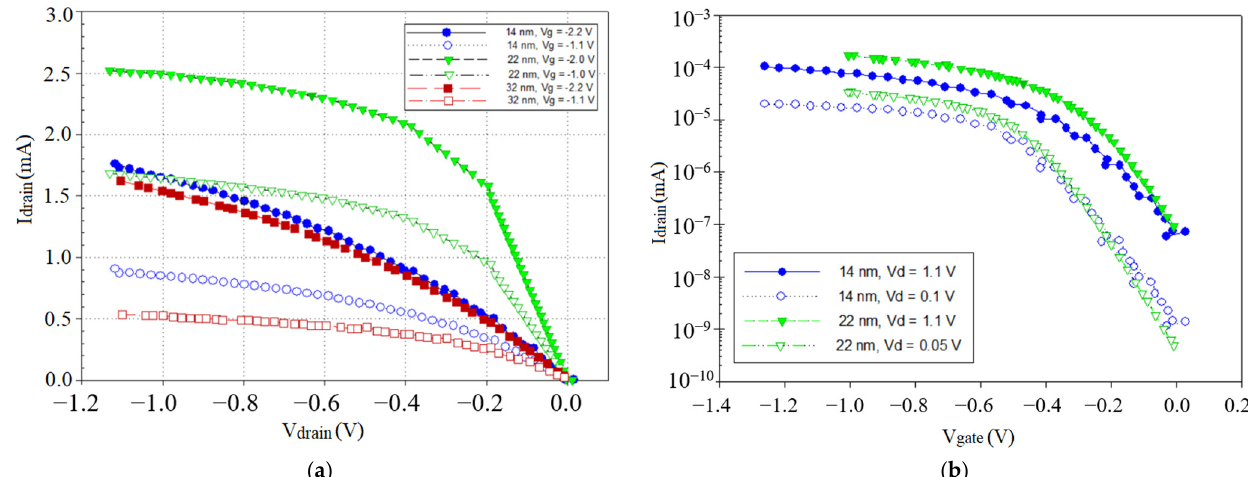
Figure 4. ( a ) Output characteristics of 14-nm-, 22-nm-, and 32-nm-gate-length planar bulk PMOSs; ( b ) transfer characteristics of 14-nm- and 22-nm-gate-length planar bulk PMOSs.